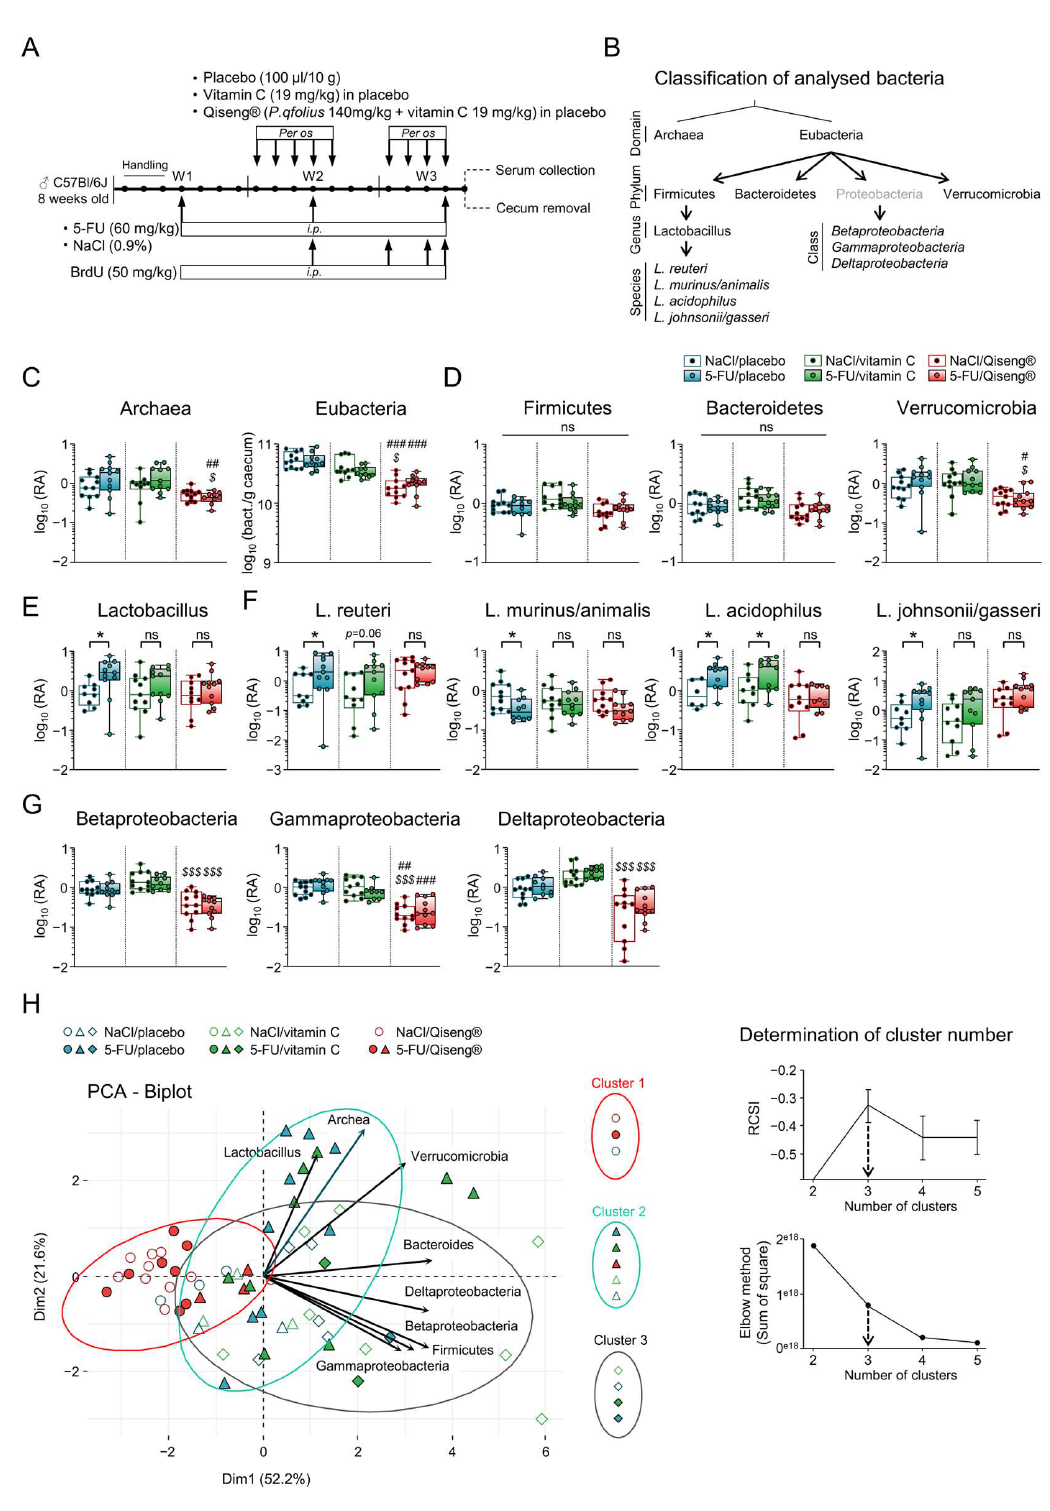
Figure 5. Impact of 5-FU, vitamin C and Qiseng ® on the abundance of selected species from the gut microbiota. (A) Schematic illustration showing the timeline for treatments and time of serum and cecum collections in mice. ( B ) Schematic illustration showing the classification and relationships between the different domains, phyla, genera, classes and species of gut bacteria quantified by qPCR. ( C – G ) Relative abundance (RA) of Archaea and Eubacteria ( C ), Firmicutes, Bacteroidetes and Verrucomicrobia ( D ), the Lactobacillus genera ( E ), L. reuteri , L. murinus/animalis , L. acidophilus and L. johnsonii/gasseri species ( F ) and Betaproteobacteria, Gammaproteobacteria and Deltaproteobacteria ( G ) from cecal contents of 5-FU/placebo, 5-FU/vitamin C and 5-FU/Qiseng ® and their respective NaCl control groups. Data are presented as whisker plots with median, minimum/maximum values